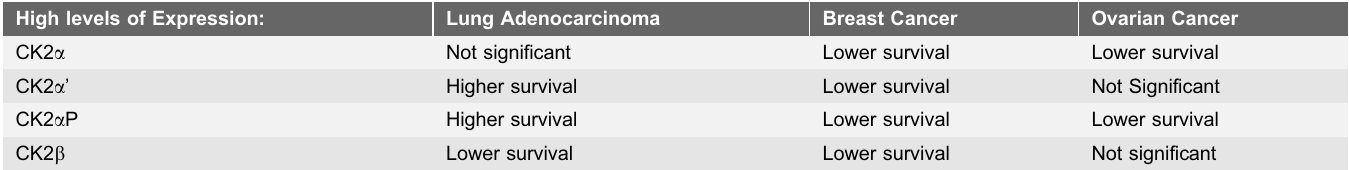
Table 9. Overall Survivability as an effect of High Gene Expression Levels. High levels of